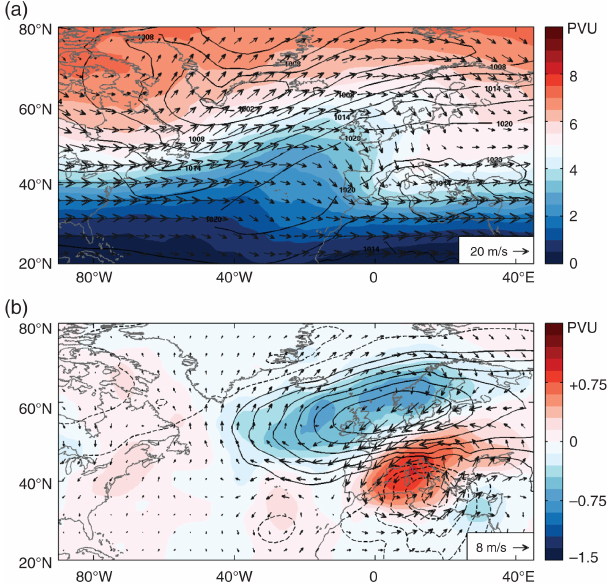
Figure 2. (a) ERA-Interim average fields of sea-level pressure (black contours), PV (shaded) and wind (arrows) on the 330K isen- tropic surface, centred at the time of maximum intensity of the 200 Mediterranean cyclones. Panel (b) is like (a) but for monthly anomalies (contours every 1hPa, dashed for negative and solid for positive values). Reprinted from Raveh-Rubin and Flaounas